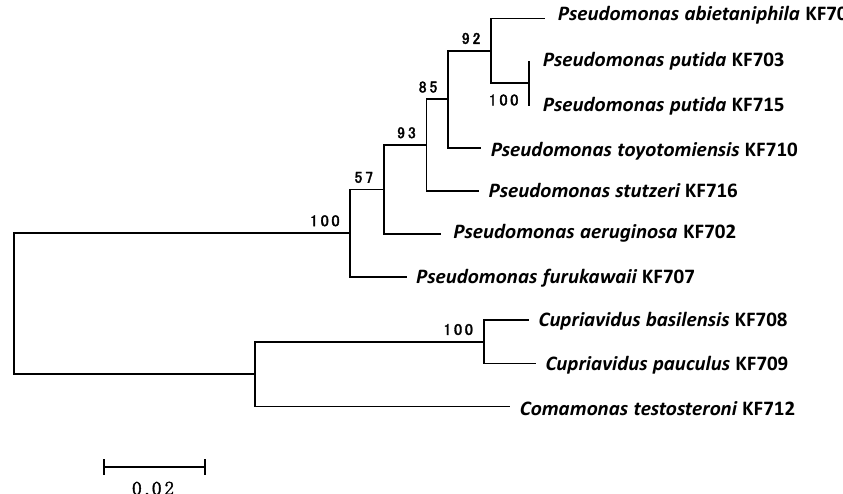
Figure 2. 16S rRNA phylogenetic trees of the ten KF strains. The multiple alignment outputs were used to generate neighbor-joining phylogenetic trees using MEGA 6.0 [33]. The bar indicates expected nucleotide substitutions per site. Numbers indicate the percentage occurrence of the branch in the bootstrapped trees on 500 replicates.